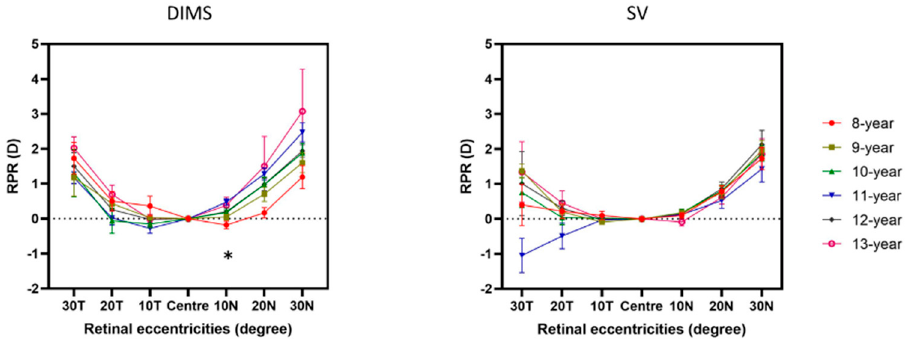
Figure 3. Baseline RPR among each age subgroup in the DIMS and SV group, respectively. * Indicated the significant difference in RPR among age subgroups after Bonferroni correction (ANOVA, p < 0.008). Error bars denote SEM. Zero horizontal lines have been shown as dashed lines.